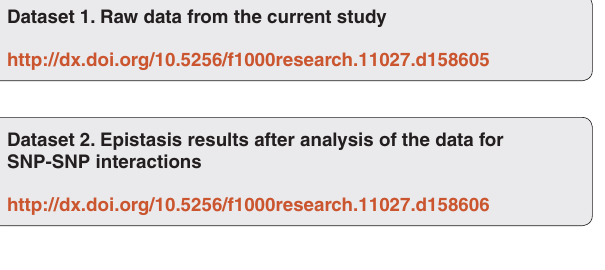
Table 1. Statistically significant SNP-SNP interactions discovered in patients with aggressive PCa when compared to healthy